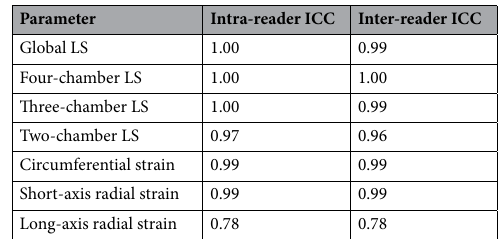
Table 4. Intra-class correlation coefficients (ICC) for intra-reader as well as inter-reader reliability of the different CT-derived strain measurements. LS longitudinal